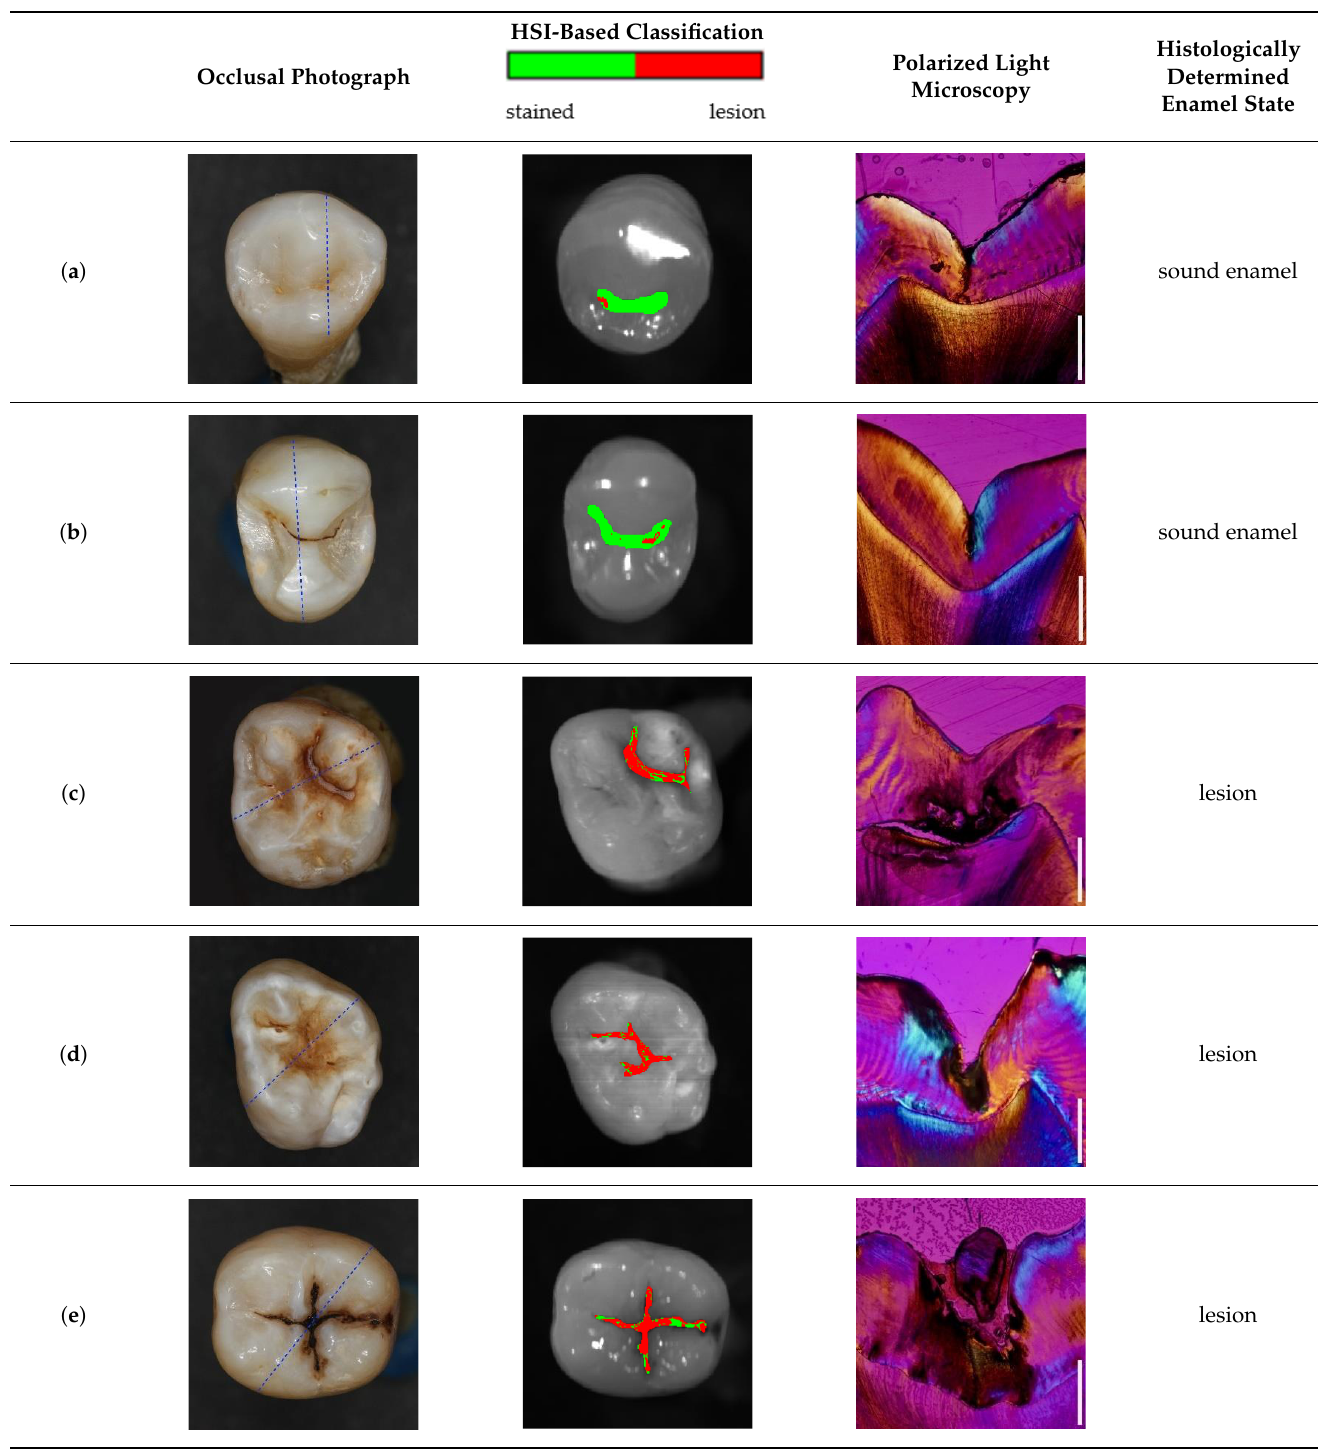
Table 3. Clinical simulation of enamel health predictions using HSI-based automated classification as a decision-support system. Five additional teeth (two stained [(a) and (b)], three stained lesion [(c) through (e)]) were imaged and classified by the previously trained fine kNN classification algorithm (i.e., the samples in this table were not included in algorithm training). Stained sound enamel is displayed green, whereas lesions (stained or unstained) are displayed red. Polarization microscopy images from each tooth’s sectional plane (dotted lines) serve as reference. All scale bars = 1 mm.